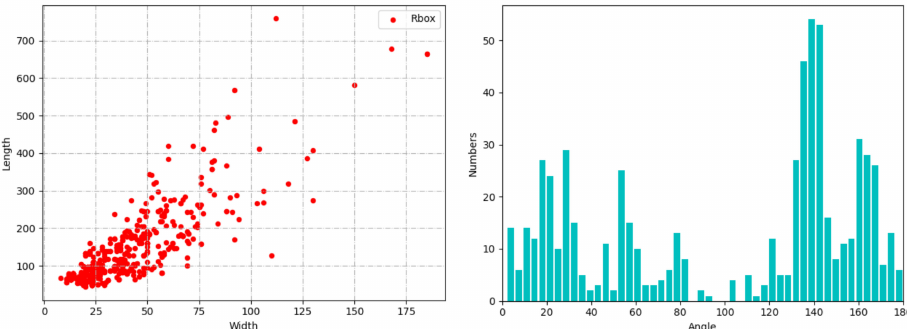
Figure 6. The distributions of the ships’ width, length, and angle on the training dataset.